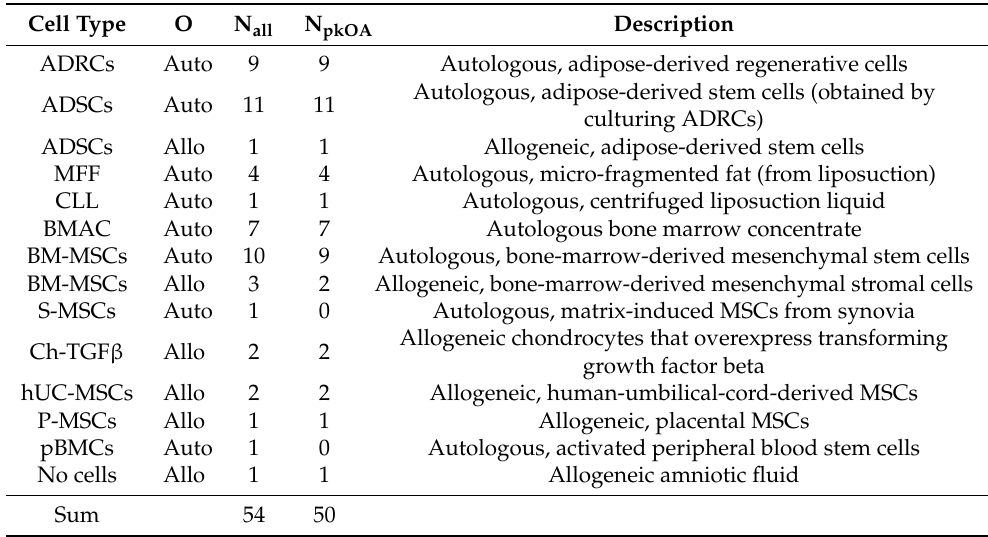
Table 3. Cell types used in those studies included in the meta-analyses summarized in Table S2 in which treatment of primary knee osteoarthritis with stem cells was investigated.